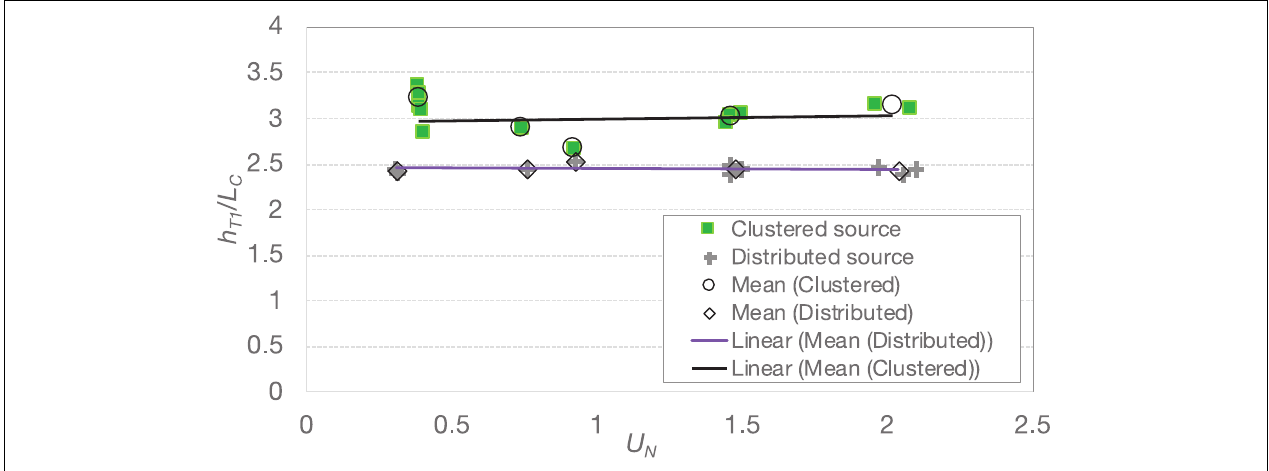
FIGURE 7 | Normalized h T 1 against U N for clustered and distributed sources. The solid trendlines are the mean of clustered (black) and distributed (gray)